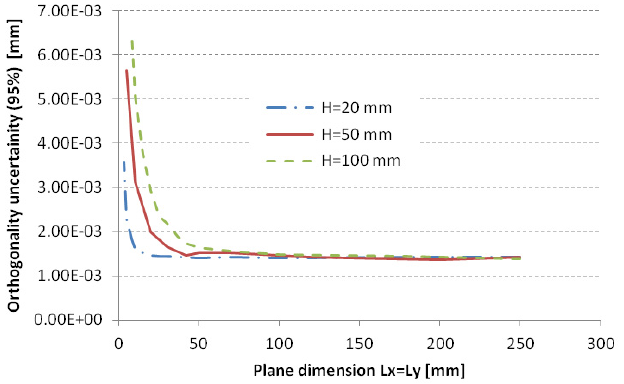
Fig. 9. Angle α uncertainty (95% percentile plotted).